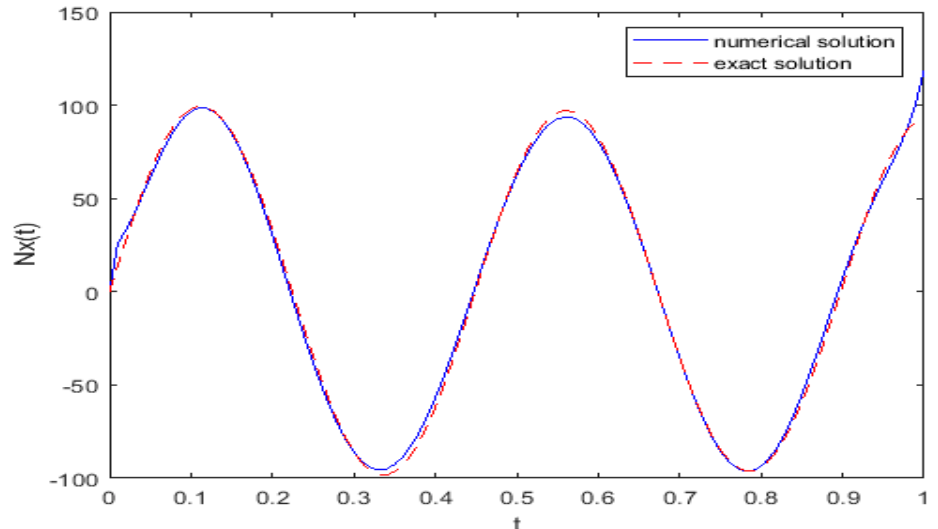
Figure 15. Numerical simulation of solutions of the Bloch equation for 𝑁 (cid:3051) (𝑡) with parameters: 𝛼 = 𝛽 = 𝛾 = 1 , 𝑤 (cid:2868) = 14 , 𝑇 (cid:2869) = 1 , 𝑇 (cid:2870) = 20, 𝑎 = 0.9, 𝑏 = 0.9 .